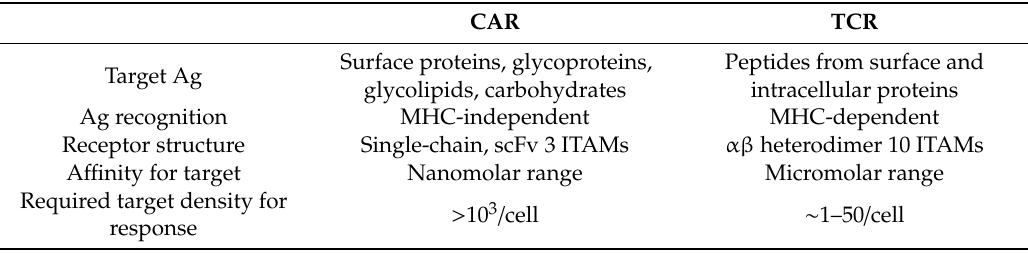
Table 1. Comparison of chimeric antigen (CAR) and T-cell receptors (TCRs). CAR TCR Surface proteins, glycoproteins, Peptides from surface and Target Ag glycolipids, carbohydrates intracellular proteins Ag recognition MHC-independent MHC-dependent Receptor structure Single-chain, scFv 3 ITAMs αβ heterodimer 10 ITAMs A ffi nity for target Nanomolar range Micromolar range Required target density for response Ag: